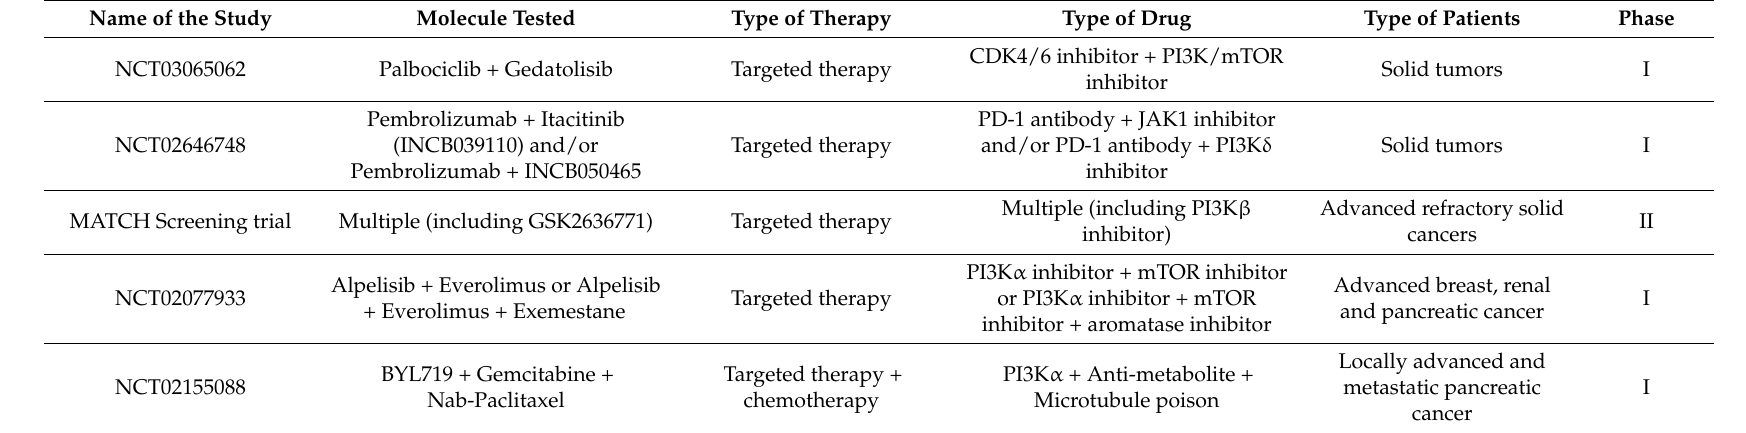
Table 5. Ongoing active clinical trials in pancreatic cancer targeting PI3K . Adapted from clinical.gouv.fr, updated in April 2018. Most phase I clinical trials using PI3K inhibitors in monotherapy or in combination therapy are completed; they include advanced pancreatic cancers (ref